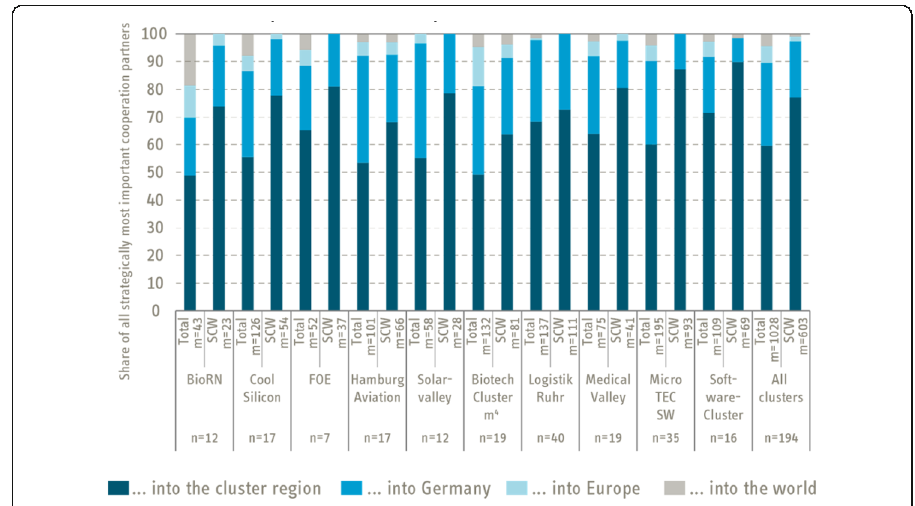
Fig. 8 Geographic distribution of strategically important collaborative relationships – comparison of the entire network of cooperation influenced by the LECC. Source: Accompanying evaluation of the LECC; written survey of LECC-funded organisations in 2011 and 2012. – Comments: n = Number of responses; m = Number of identified relationships within the cooperation